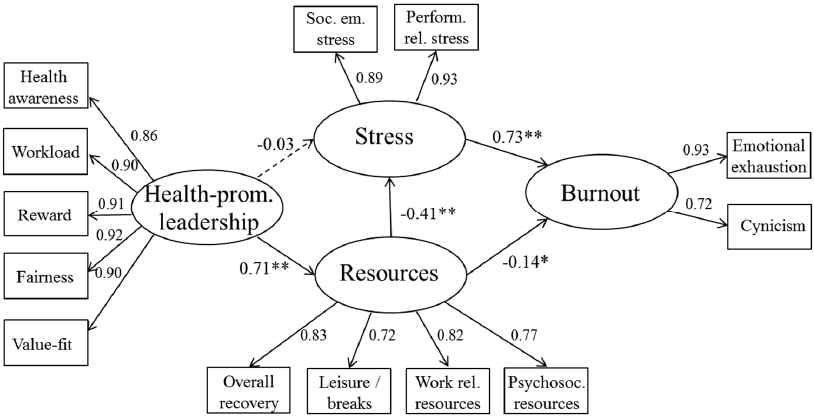
Figure 3. Structural Equation Modeling (SEM)—sample 2. ** paths are significant at p < 0.001; * paths